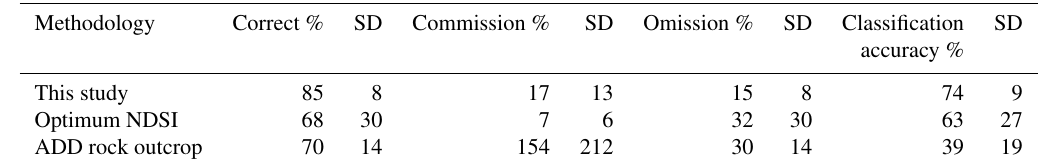
Table 1. Summary of mean accuracy assessment vales for the 10 images evaluated.